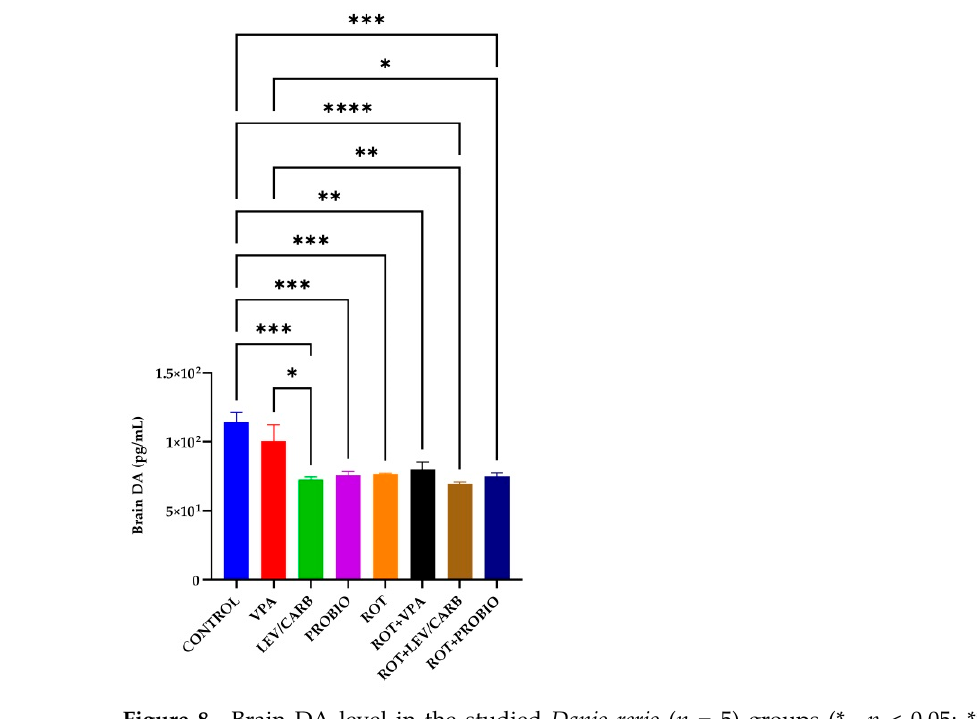
Figure 8. Brain DA level in the studied Danio rerio ( n = 5) groups (*— p < 0.05; **— p < 0.005; ***— p < 0.0005; ****— p < 0.0001; values expressed as mean with SEM followed by Tukey HSD).